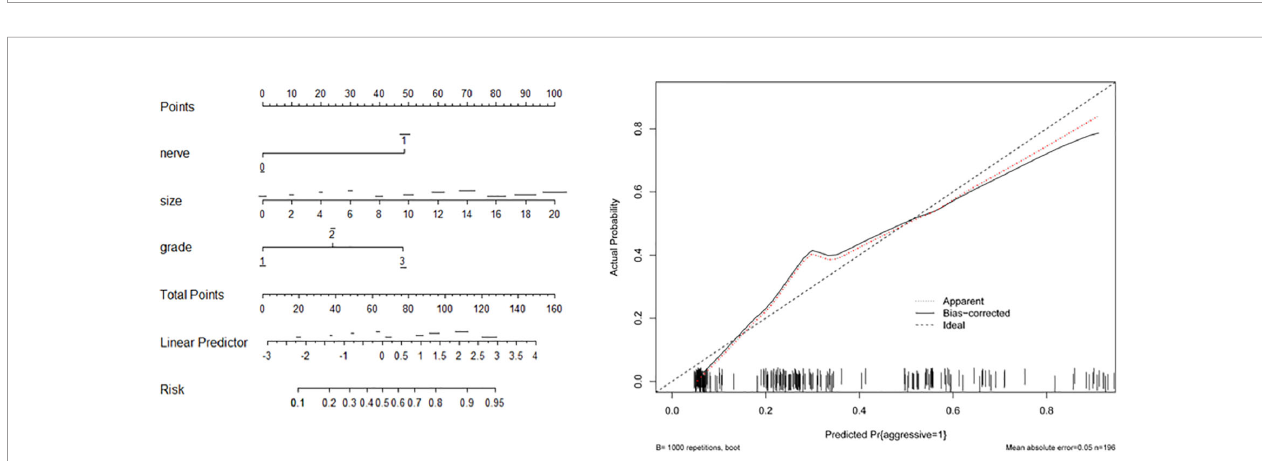
FIGURE 1 | Nomogram (left) and calibration curve (right) of aggressive behavior of pancreatic neuroendocrine tumors (PNETs) in total patients. Neural invasion (nerve), tumor size, and tumor grade were included in the gram.